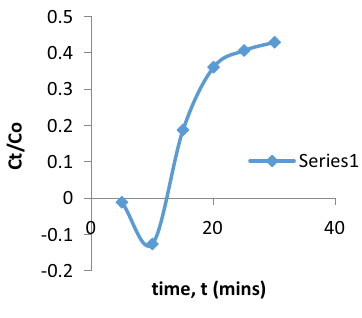
Fig. 5 Breakthrough curve at 40 mg/L